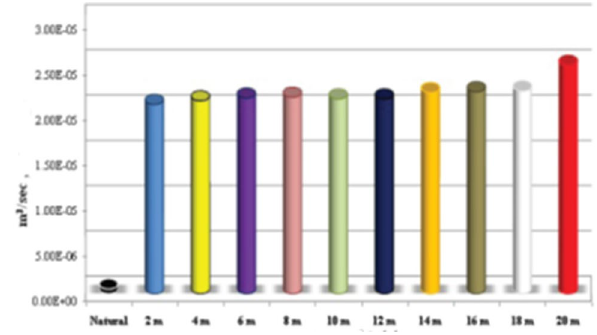
Fig. 13 A section of the hydraulic gap in an area where cutting of natural gaps is a major factor in increasing production